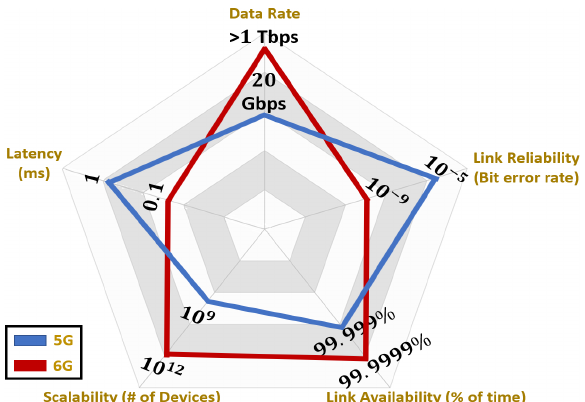
Figure 6. A comparison between 5G and 6G’s theoretical achievable